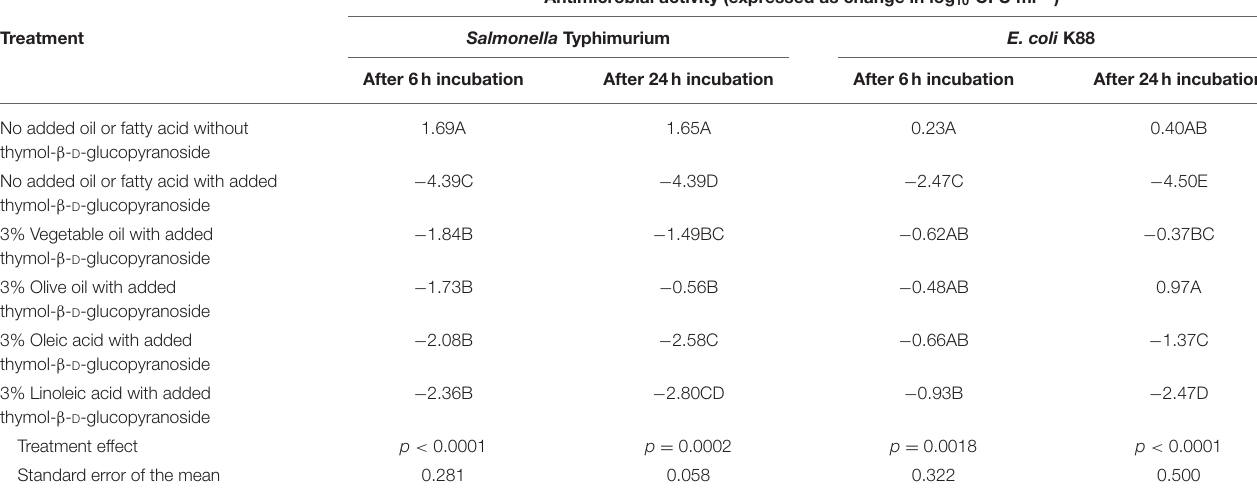
TABLE 2 | Effect of different oil substrates or their predominant free fatty acids on anti- Salmonella Typhimurium and anti- E. coli K88 activities of thymol- β - D -thymol (6mM) during mixed culture with porcine fecal microbes.